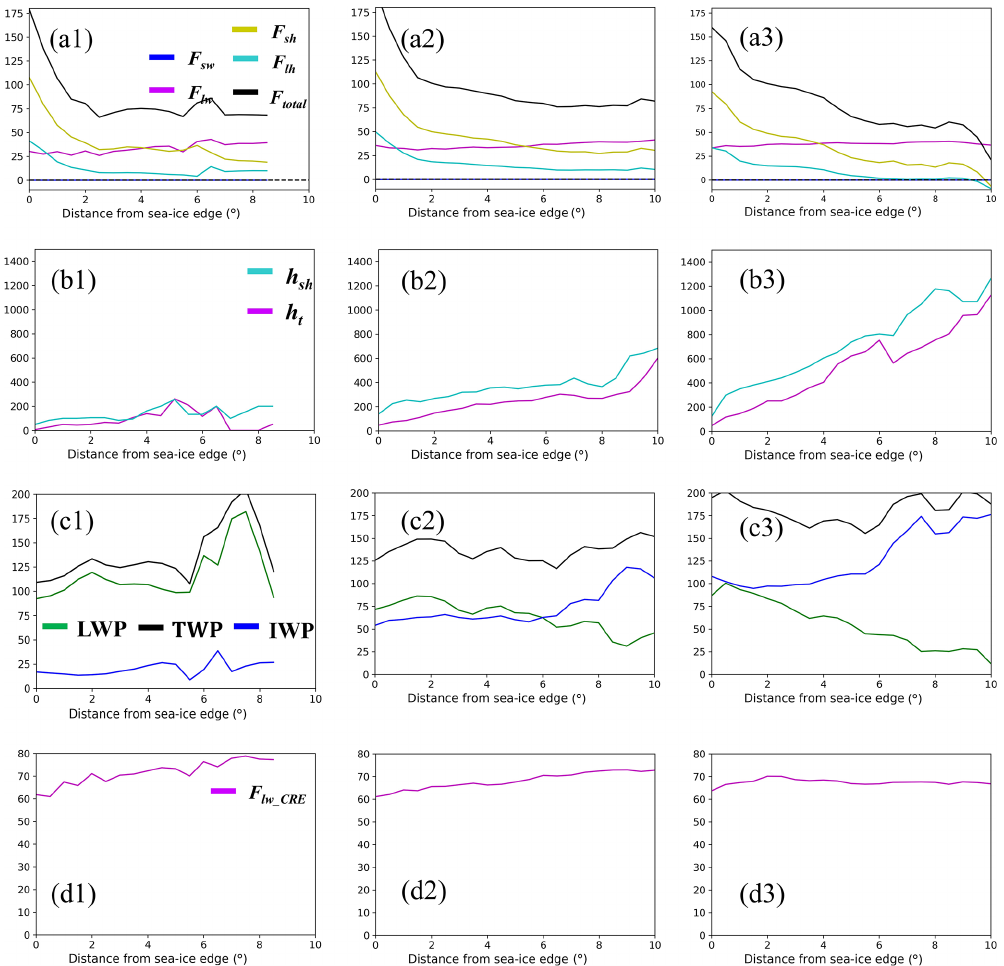
Figure 16. Average variation of (a1) the sum ( F total , Wm − 2 ; black) and individual surface fluxes of sensible heat ( F sh , Wm − 2 ; yellow), latent heat ( F lh , Wm − 2 ; cyan), net longwave irradiance ( F lw , Wm − 2 ; magenta) and net shortwave irradiance ( F sw , Wm − 2 ; blue); (b1) the height to the maximum specific humidity ( h sh ) and temperature ( h t ); (c1) liquid water path (LWP; gm − 2 ), ice water path (IWP; gm − 2 ) and total water path (TWP; gm − 2 ); (d1) the cloud radiative effect by longwave irradiance ( F lw_CRE ; magenta), with the downstream northward distance from sea-ice edge, along the trajectory of WaMAI in category of RAD over the Barents Sea. Panels (a2) , (b2) , (c2) and (d2) ( a3, b3, c3, d3 ) are the same but for WaMAIs in category of TBL